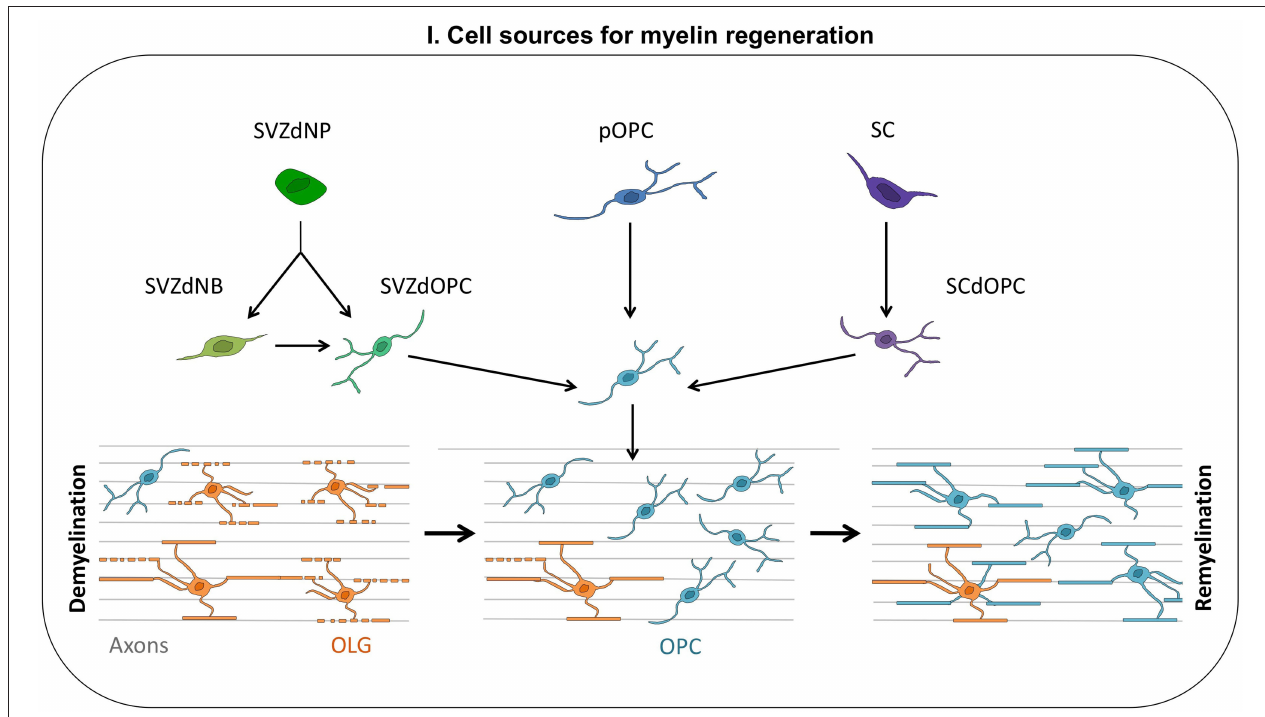
FIGURE 1 | Cell sources for myelin regeneration. Following a demyelination insult, oligodendrocyte progenitor cells (OPCs) are mobilized: they proliferate, migrate toward the injury, and finally differentiate into new myelinating oligodendrocytes (OLGs). These OPCs contributing to myelin repair may be derived from the subventricular zone (SVZdOPC) [directly or by reprogramming of neuroblasts (SVZdNB)], from embryo-derived OPCs (pOPC) or from Schwann cells (SCdOPC). Surviving OLG can also produce new myelin segments thus contributing to